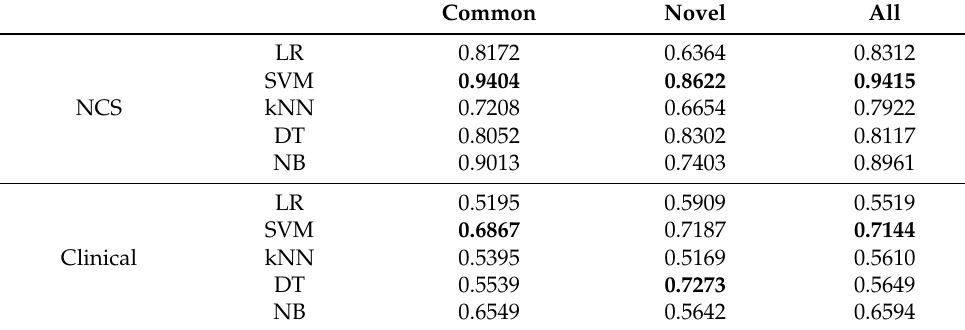
Table 3. Three-class Problem Classification Accuracy.